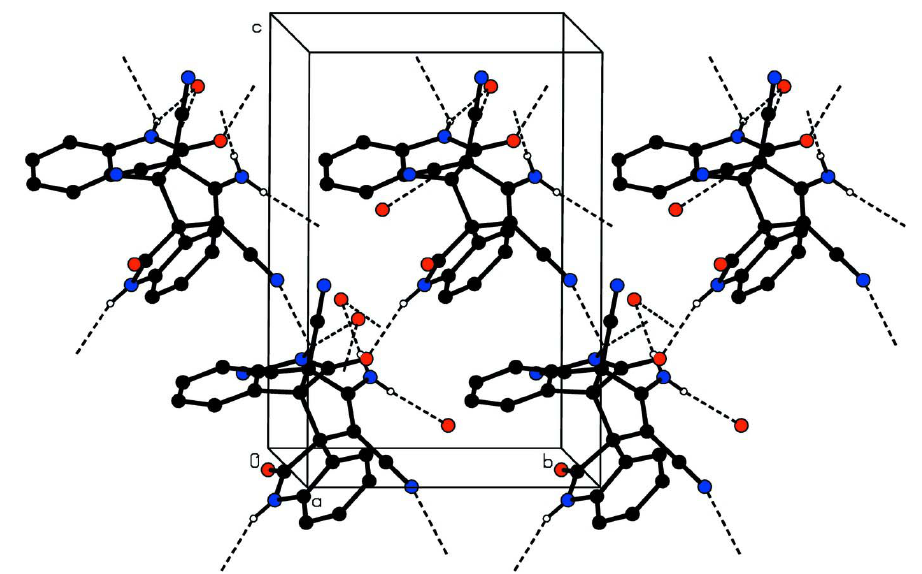
Figure 3 The molecular packing viewed down the a axis, showing N—H···O intermolecular interactions. 4 ′ -Amino-2,2 ′′ -dioxo-2,2 ′′ ,3,3 ′′ -tetrahydro-1 H -indole-3-spiro-1 ′ -cyclopent- 3 ′ -ene-2 ′ -spiro-3 ′′ -1 H - indole-3 ′ ,5 ′ ,5 ′ -tricarbonitrile